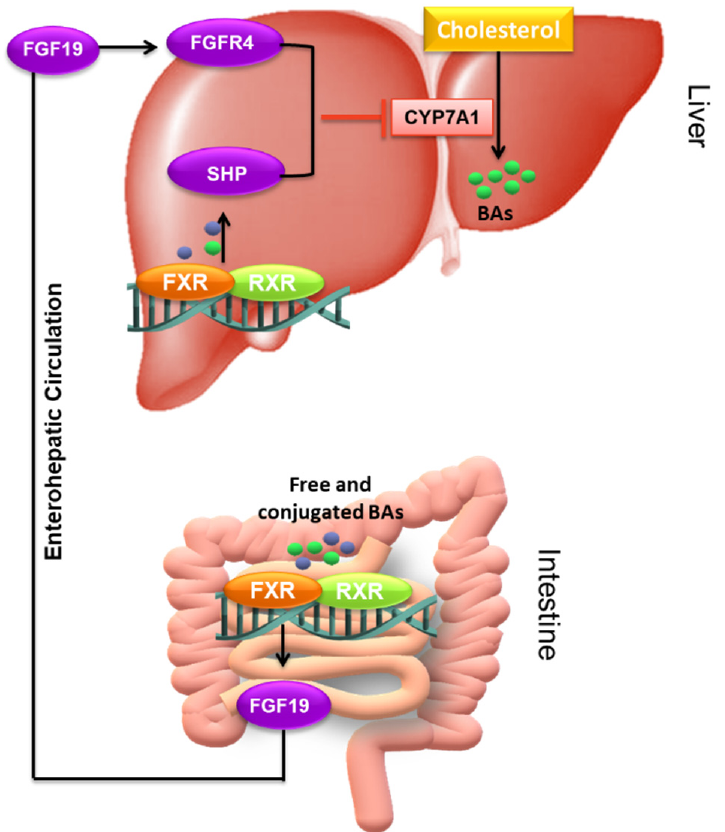
Figure 5. Schematic representation of the role of FXR in the regulation of BAs synthesis. BAs that travel back in the enterohepatic circulation (EHC) activate hepatic and intestinal FXR to regulate genes important for BAs synthesis. The activation of FXR in the gut induces human fibroblast growth factor (FGF)-15/19 (15 in mice and 19 in humans, respectively) expression, which is secreted through the circulation to the liver. Here, it binds and activates the FGFR-4, which in turn inhibits CYP7A1 expression. Moreover, the activation of hepatic FXR represses BAs synthesis by reducing CYP7A1 expression via SHP induction. The figure is original and created with BioRender.com. FXR regulates not only the BAs pool but also BAs uptake and export systems by inducing some binding proteins and transporters, i.e., IBABP and OST α /OST β or by inhibiting other ones, such as NTCP and ASBT [95]; so, any alteration of normal intestinal FXR expression and activity associated with compromised BAs homeostasis leads to the augmented production of cytotoxic, proinflammatory, and pro-tumoral secondary BAs [34]. Thus, BAs synthesis is under negative-feedback control through the different enterohepatic FXR-dependent signaling axis. During cholestasis, when high levels of BAs are present